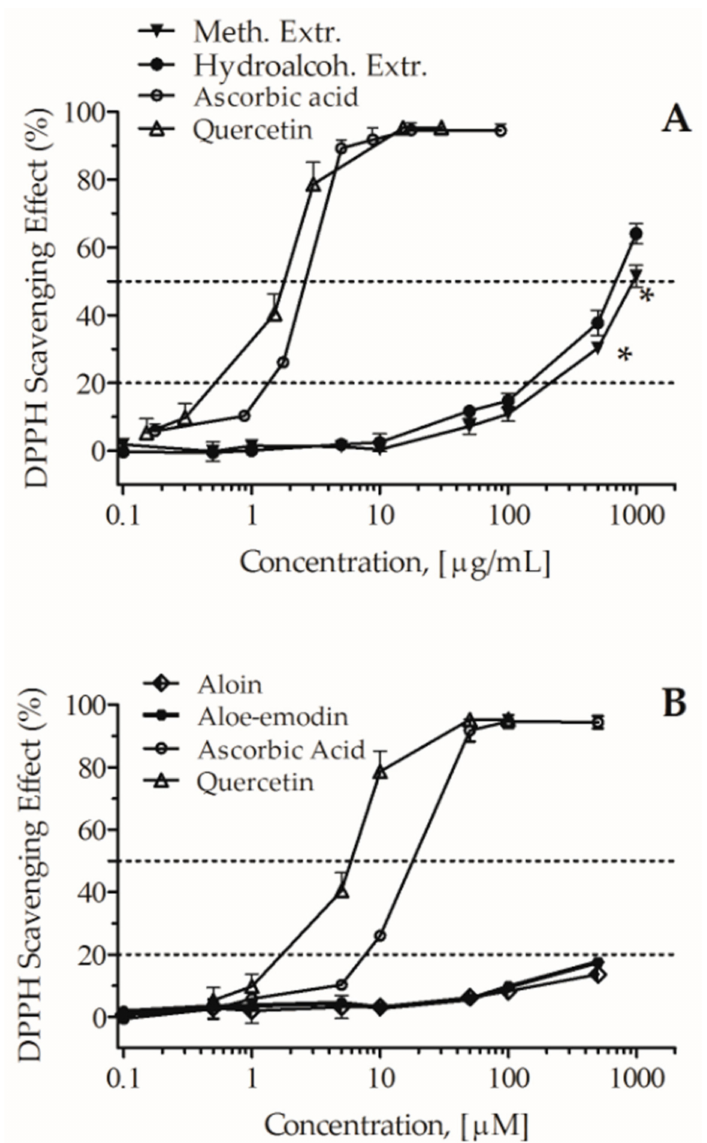
Figure 3. Antiradical activity of the methanolic (Meth.) and hydroalcoholic (Hydroalcoh.) A. arborescens extracts ( A ), and aloin and aloe-emodin ( B ). Ascorbic acid and quercetin were used as positive controls. Extr: extract. * p < 0.05 vs. hydroalcoholic